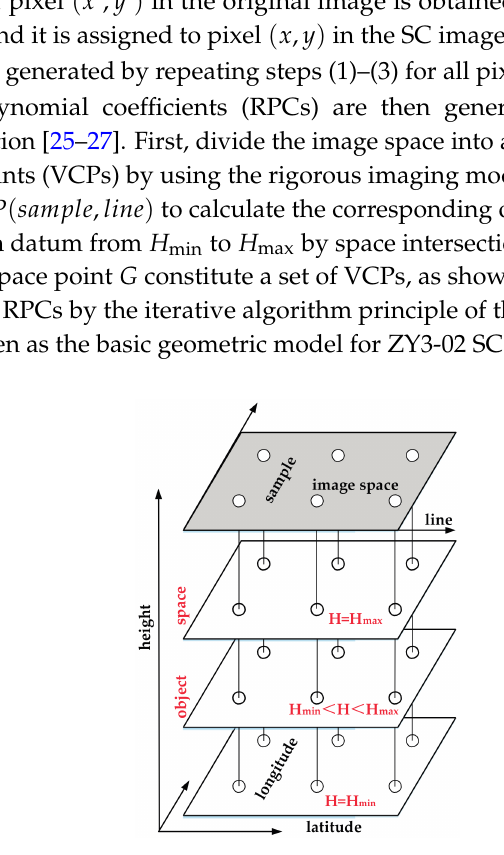
Figure 4. Schematic diagram of the virtual control points.